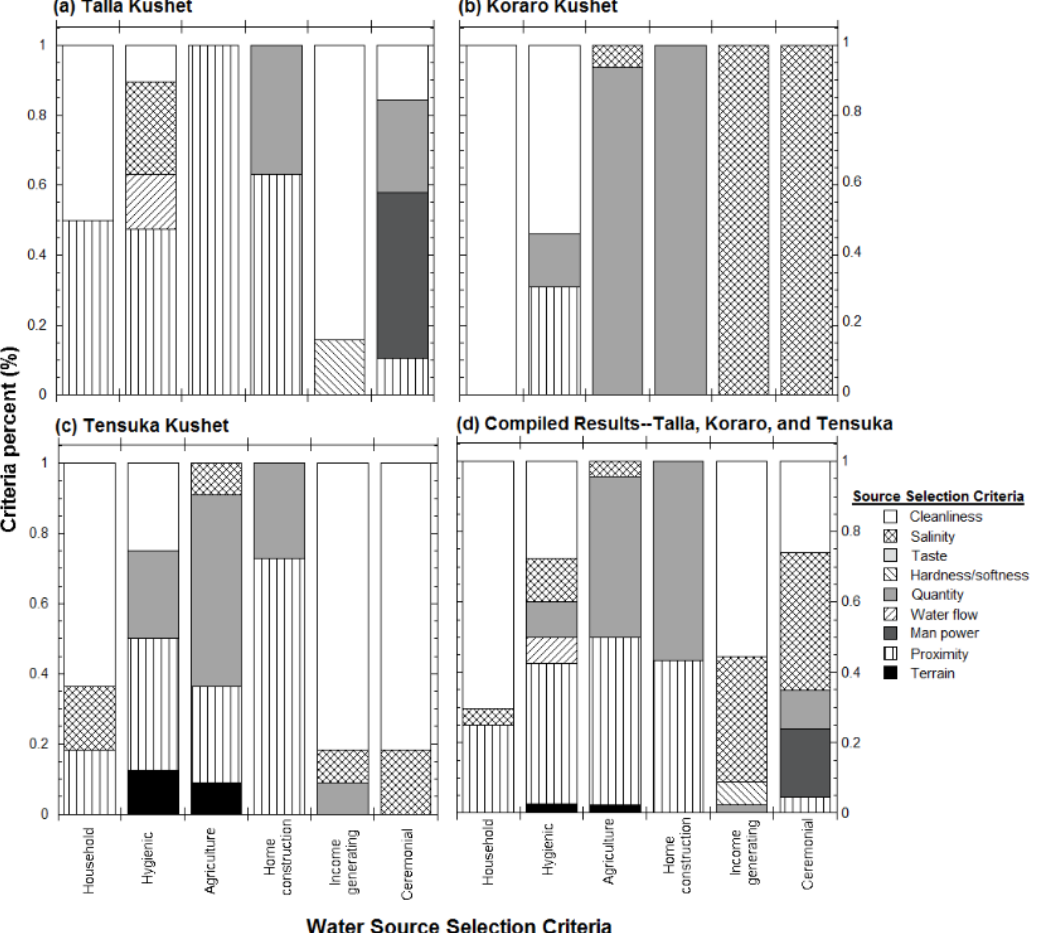
Figure 2. Water use criteria according to use and Kushet location: ( a ) Talla Kushet; ( b ) Koraro Kushet; ( c ) Tensuka Kushet; and ( d ) compiled results from all three Kushets.